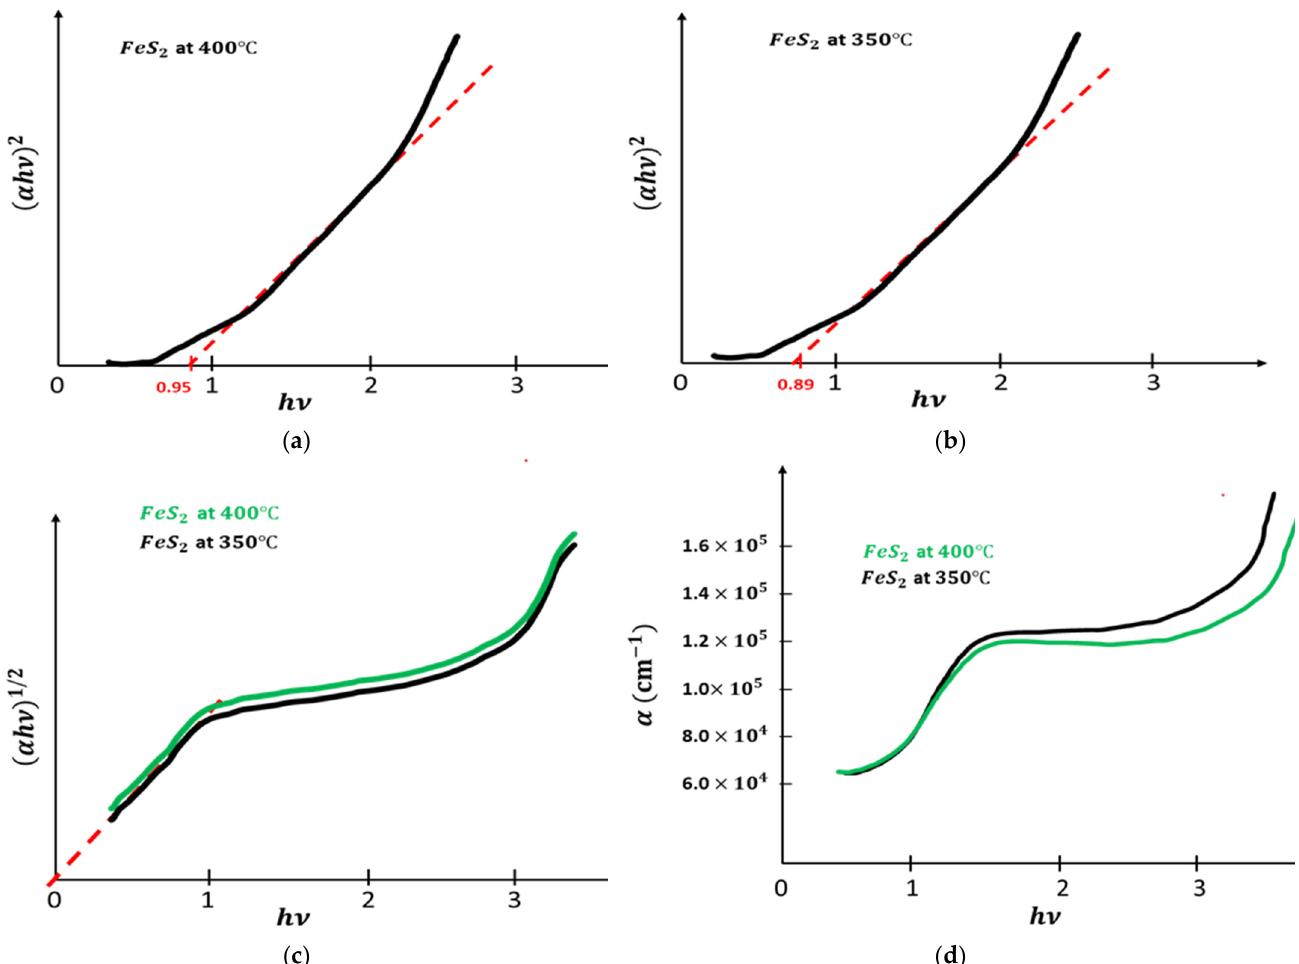
Table 3. Exprimental band gap.